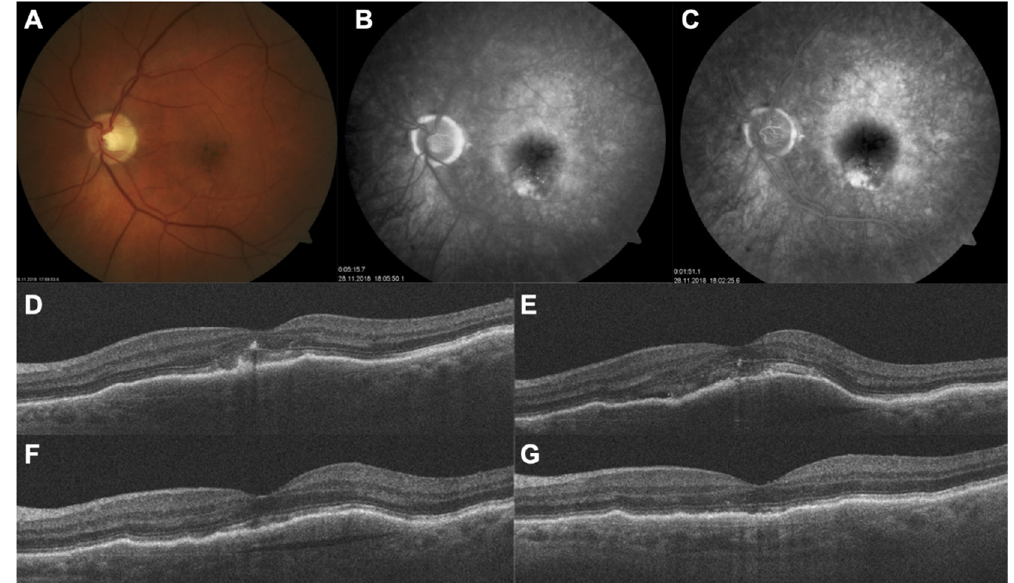
Figure 2. A 74-year-old male with neovascular AMD was switched to brolucizumab after demonstrating worsening of anatomical changes despite six consecutive injections of aflibercept followed by six consecutive injections of ranibizumab. ( A – D ) Multimodal imaging showing the baseline situation before any anti-VEGF therapy. ( E ) SD-OCT showing the condition of the retina immediately prior to initiation of brolucizumab therapy. Large pigment epithelium detachment (PED) was present, associated with persistent subretinal fluid (SRF). ( F ) SD-OCT demonstrating significant improvement after the first intravitreal brolucizumab injection and further resolution of PED and SRF. ( G ) SD-OCT after the second injection. The patient has continued to receive therapy in the q12w dosing regimen.